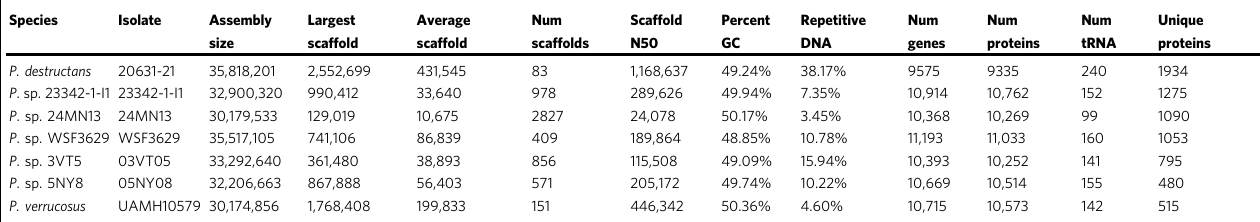
Table 1 Genome summary statistics of P. destructans and nonpathogenic Pseudogymnoascus species Species